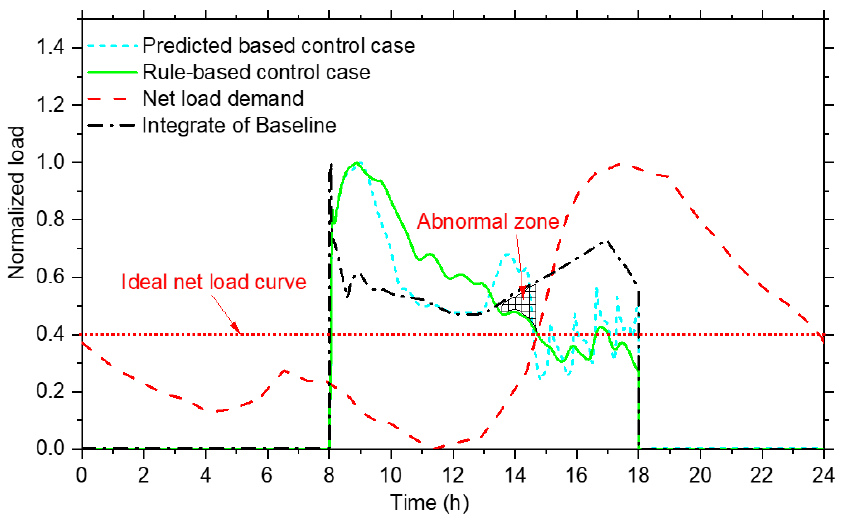
Figure 9. Normalized load curve of rule-based and prediction-based demand response (DR) control in Scenario 1.